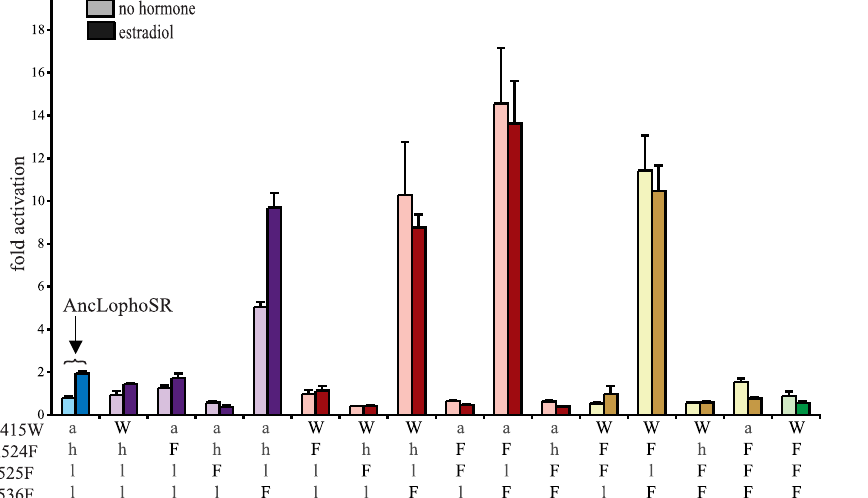
Figure 4. Two historical substitutions recapitulate the evolution of constitutive activity. Hormone-dependent transcriptional activation by the ancestral lophotrochozoan SR (AncLophoSR) and mutants containing all possible combinations of ancestral or derived states at four candidate sites was assessed using a dual luciferase assay. Lower case letters denote ancestral states; derived states in the mollusk ER are shown as upper case. Colors indicate number of residues with derived states: blue (zero), purple (one), red (two), yellow (three), and green (four). Fold activation (luciferase activity relative to vector-only control) is shown as mean and SEM over three experiments with three replicates each.